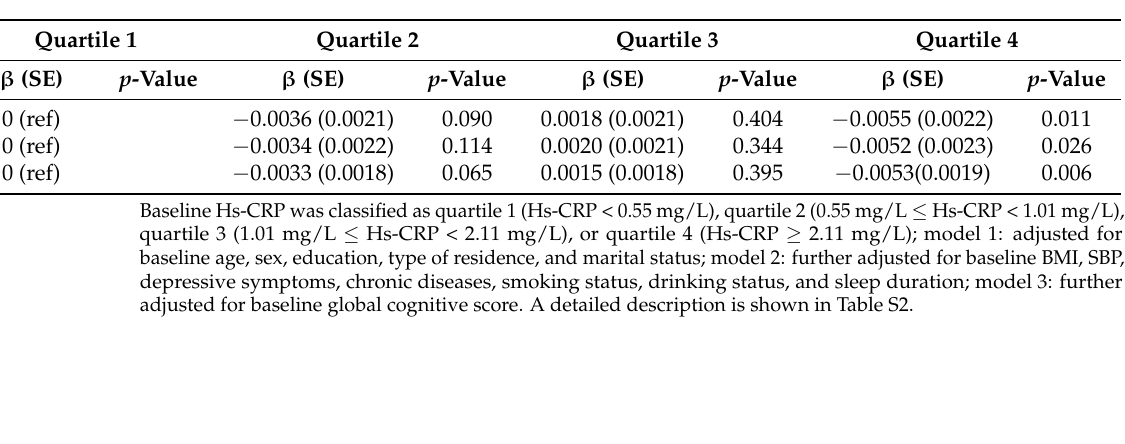
Table 2. Longitudinal analysis of mean difference in rate of change in global cognitive decline